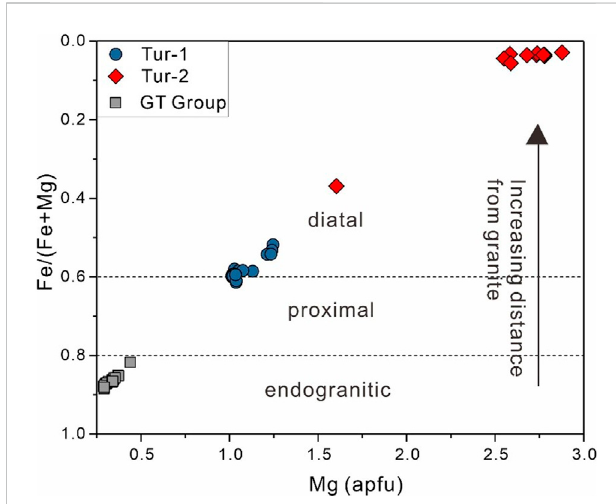
FIGURE 10 Fe/(Fe+Mg)vs.MgdiagramofthetourmalinefromtheCuonadong Sn – W – Be polymetallic deposit, indicating the traveling distance of tourmaline-forming hydrothermal fl uids. The compositions of the magmatic tourmaline in the leucogranite in the Xianglin area (GT group, gray square) are obtained from Xie et al. (2022).